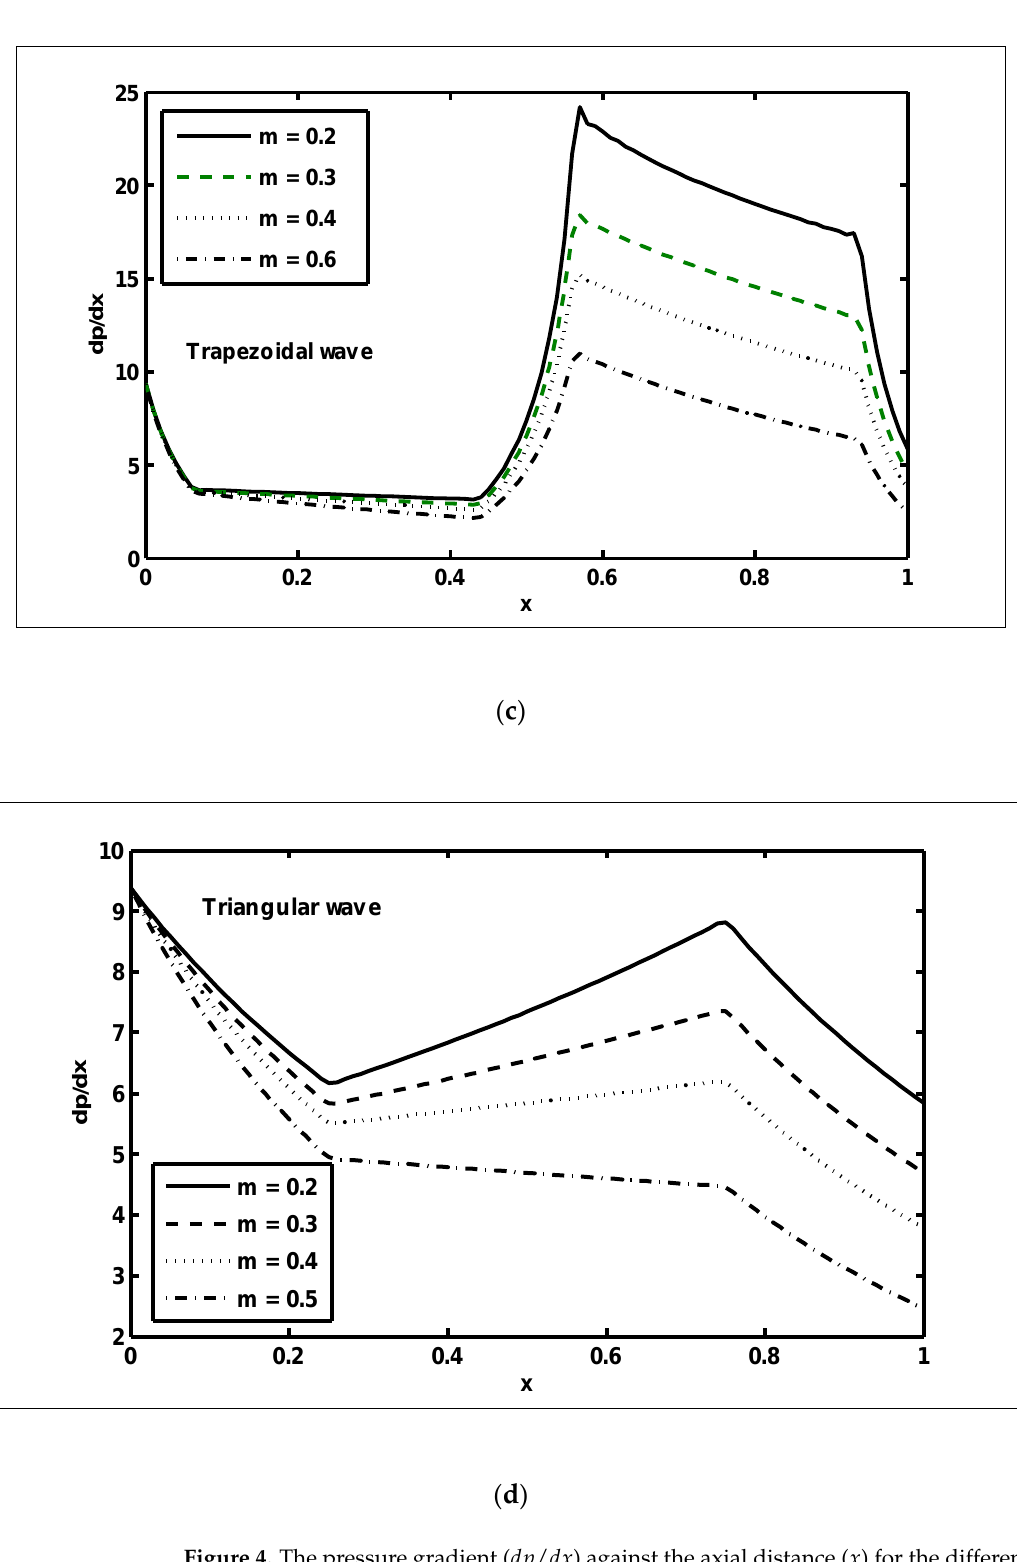
Figure 4. The pressure gradient ( dp / dx ) against the axial distance ( x ) for the different wave shapes: The various parameters used in ( a – d ) are as: N CT = 0.3, N TC = 0.7, G rc = 0.4, G rF = 0.1, G rt = 0.5, N t = 0.7, N b = 0.9, M = 4, φ = π , Γ = 0.8, β = 0.4, m = 0.4, Q = − 6